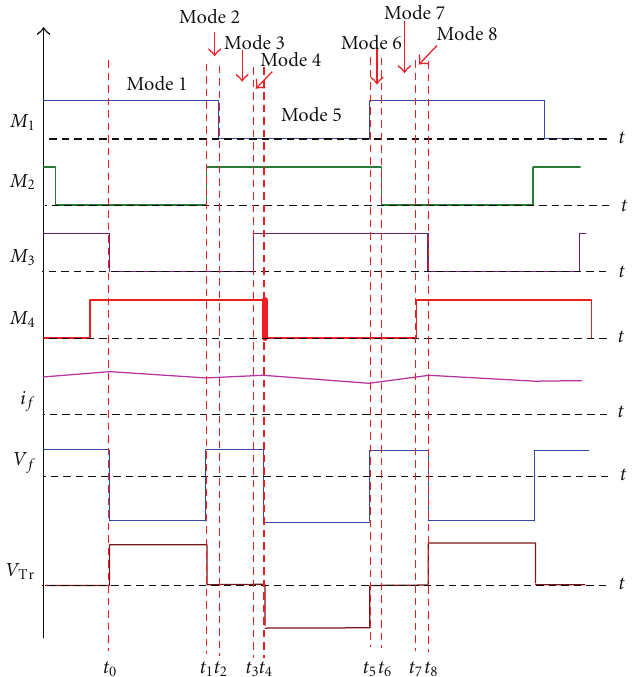
Figure 3: Driving signal of switches ( M 1 ∼ M 4 ) and conceptual current and voltage waveforms of key